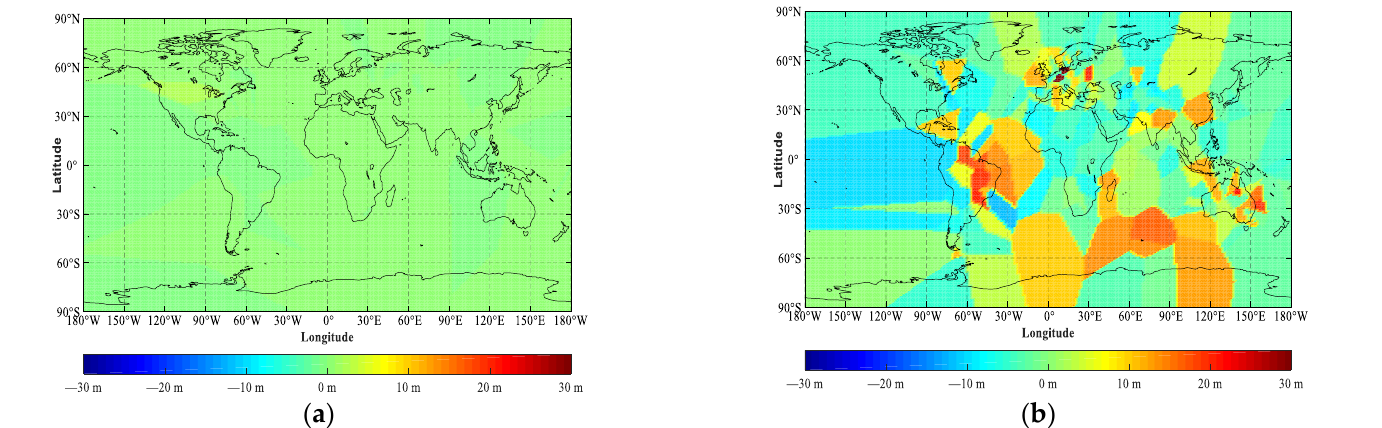
Figure 2. Global test statistics distribution of CODM based on (a) GPS and (b) BDS observation under case1 and case2.